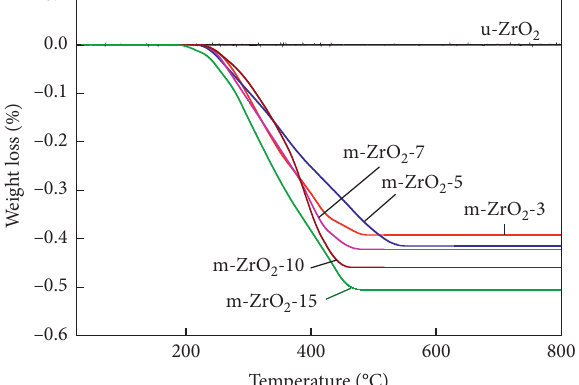
Figure 1: TG diagrams of unmodified and modified ZrO